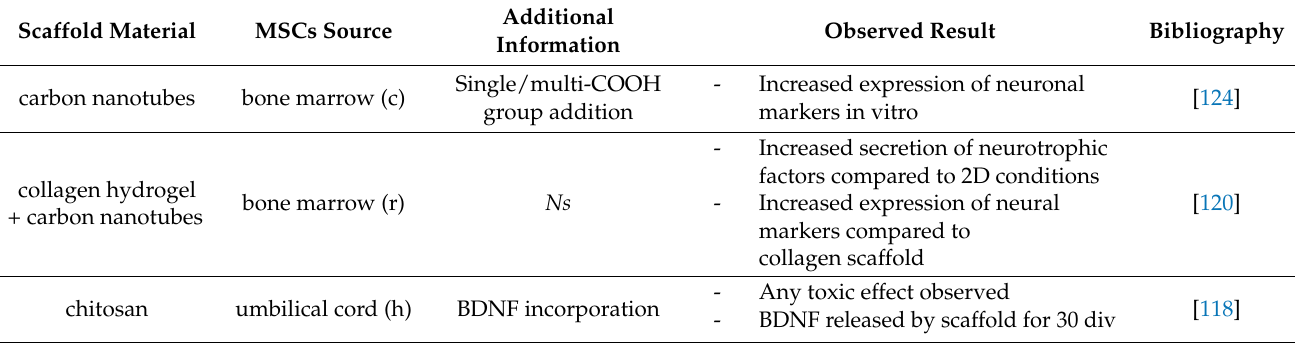
Table 3. Neural scaffolds for